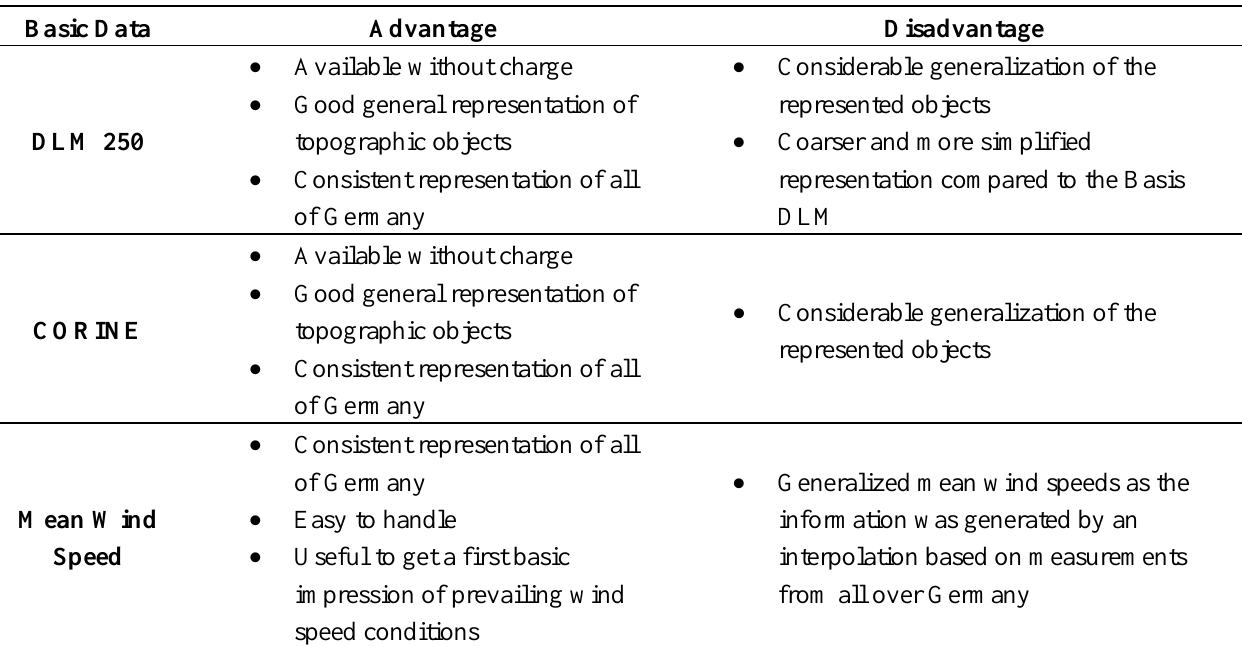
Table 3. The advantages and disadvantages of the main data